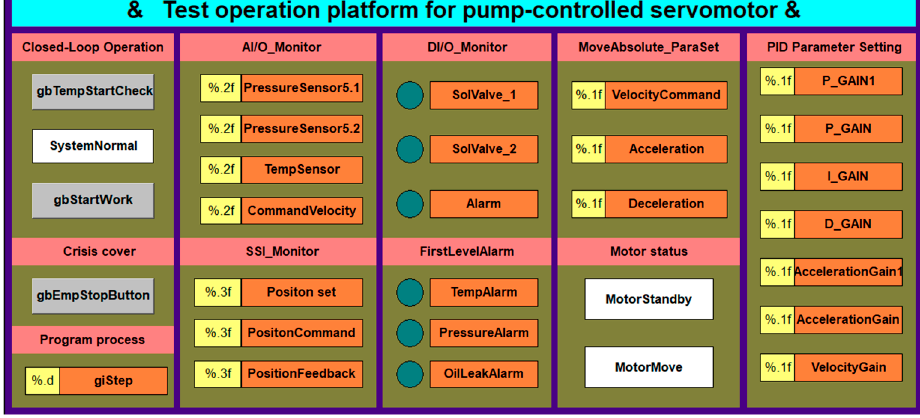
Figure 6. The test operation platform for the PCSM. The working parameters of the PCSM test platform are shown in Table